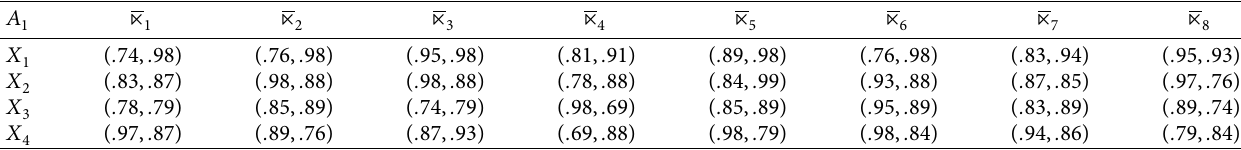
Table 7: Decision matrix for alternative ( A